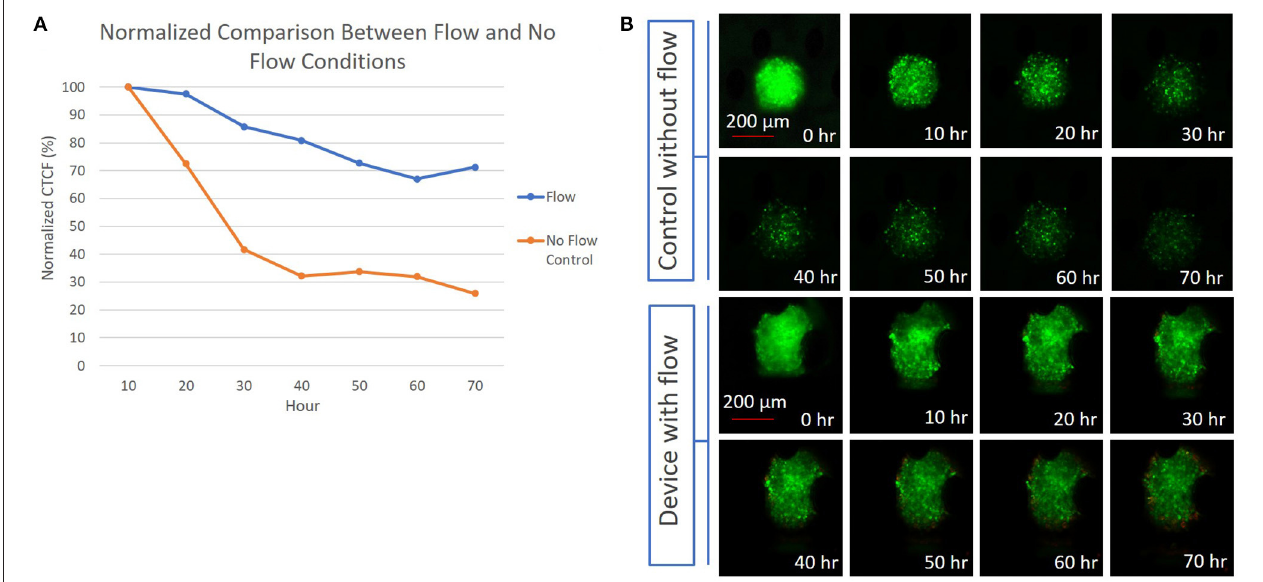
FIGURE 4 | (A) Graph depicting the difference between the normalized CTCF values associated with the flow and no-flow control conditions over the course of 70h; (B) (Top) 300 µ m diameter CT26 spheroid in a device without flow, with images showing a reduction in fluorescent intensity presumed to be due to cell death over 70h. (Bottom) 300 µ m diameter CT26 spheroid in a device with perfusion flow, showing a less significant decrease in fluorescent intensity over